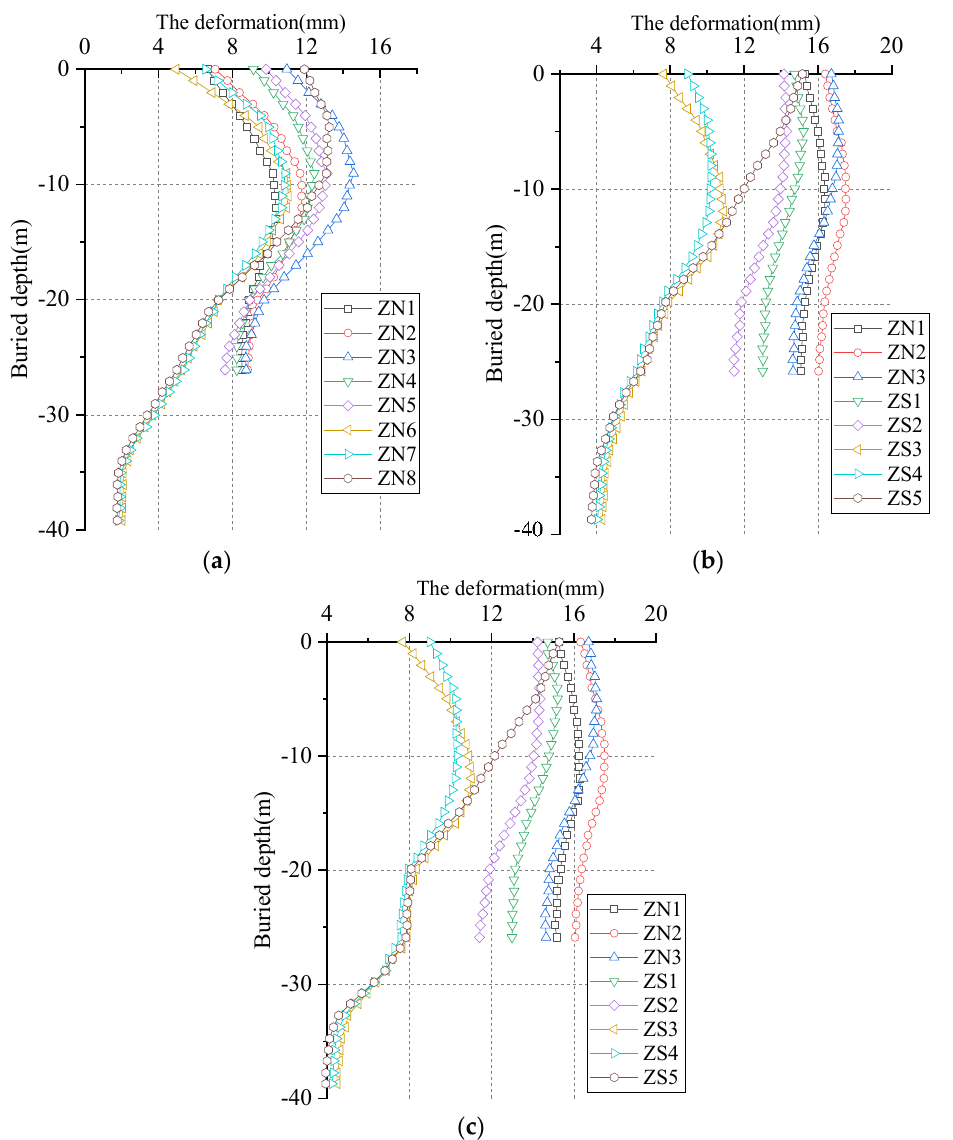
Figure 20. Deformation of the shared retaining structure under working Condition 5. ( a ) excavate to the bottom of the first layer. ( b ) excavate to the bottom of the second layer. ( c ) excavate to the bottom of the foundation pit.